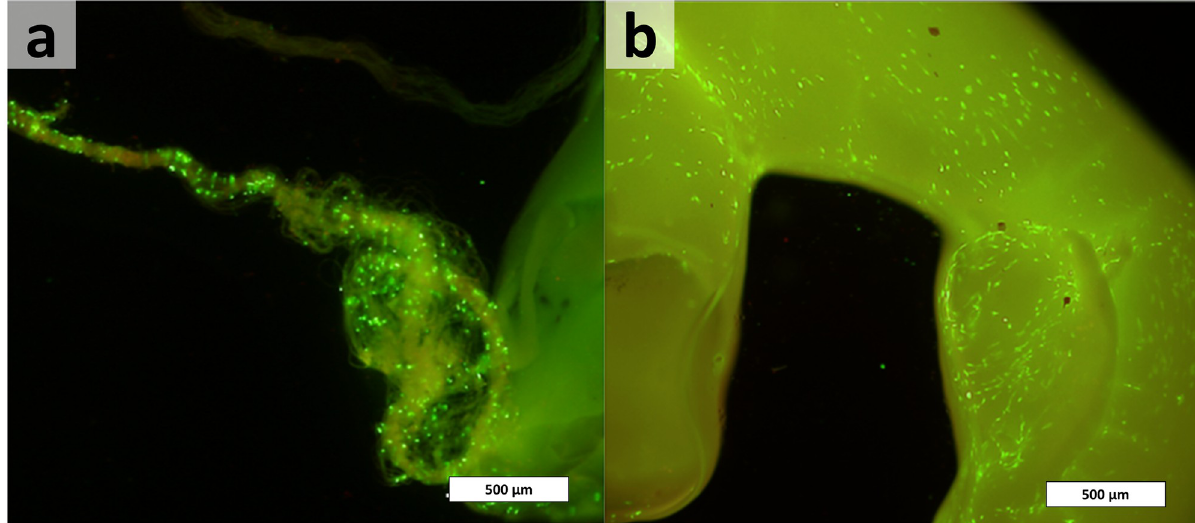
Fig 2. Life/dead assay. Spider silk (a) and fibrin scaffold (b) were seeded with olfactory ensheathing cells. Vital cells are green, while apoptotic cells (barely visible) appear red. Orange-red spider silk autofluorescence is faintly visible in a. Scale bars pertain to 500 μ